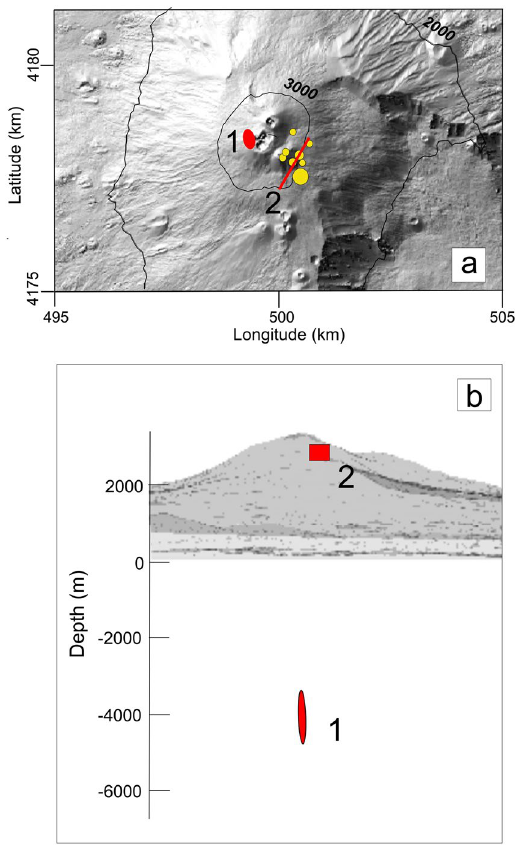
Figure 4. Surface ( a ) and vertical projection ( b ) of the analytical models of the deformation patterns. Inflating pressure source (1) for the first period (21 August - 25 December 2014) and tensile dislocation (2) related to the 28 December 2014 event. The yellow circles indicate seismic event locations (small circles: LP events taking place on 28 December at ~16:00–17:00; big circle: Ml = 3 event occurring on 28 December at 16:50). This figure was created using CorelDRAW ™ graphic suite software (http://www.corel.com/it/). The topography is based on a DEM held by INGV-OE, Cartography Lab (http://geodb.ct.ingv.it:8088/geonetwork/srv/ita/main.home).